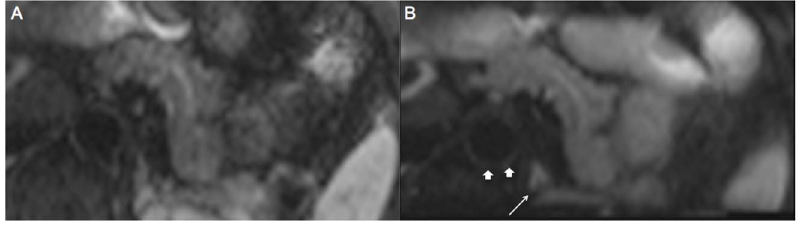
Figure 2. A 47-year old patient with c-EPI DWI (A) and z-EPI DWI (B) of the pancreas. z-EPI DWI demonstrates less distortion and a more homogeneous delineation of the pancreatic body. Also structures adjacent to the pancreas like the adrenal gland (thin arrow) and the aorta (arrows) are better delineated more sharply with z-EPI.